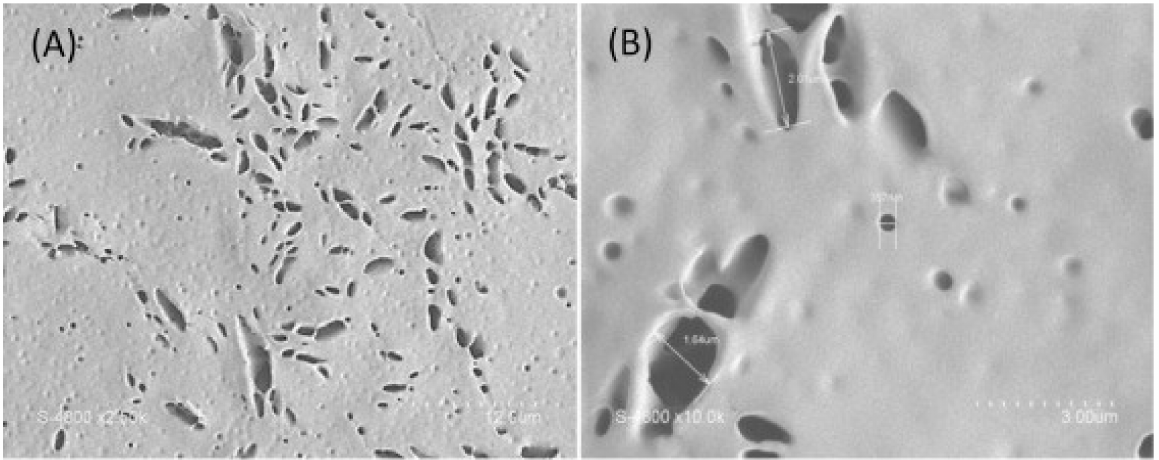
Figure 11. SEM images of PLA-b-PEG-b-PLA inverse micelle membrane with heparin in different magnifications ( A ) higher magnification and ( B ) lower magnification. Reprinted from [83], Copyright (2015) with permission from